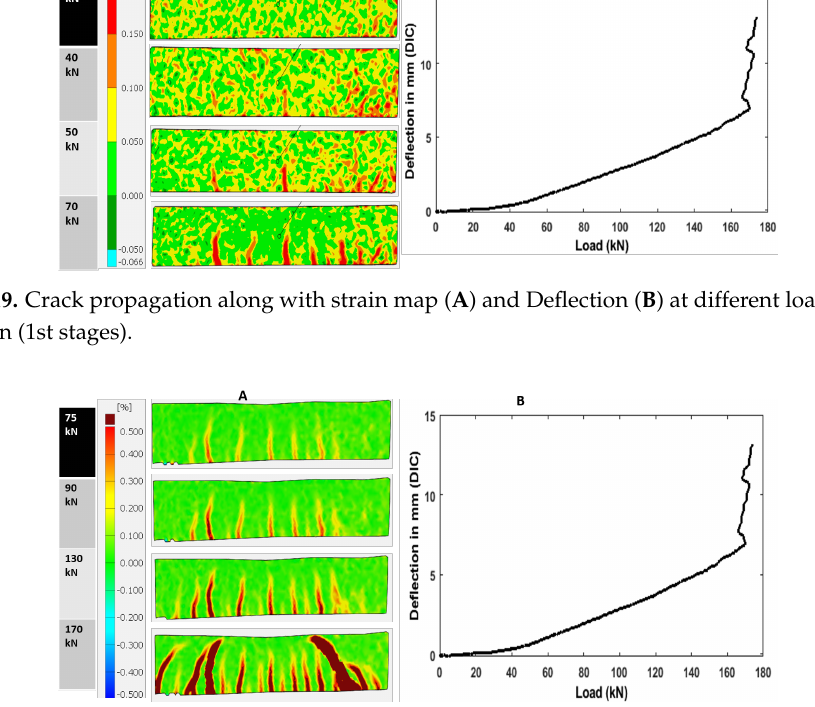
Figure 20. Crack propagation along with strain map ( A ) and Deflection ( B ) at different load levels of specimen (2nd